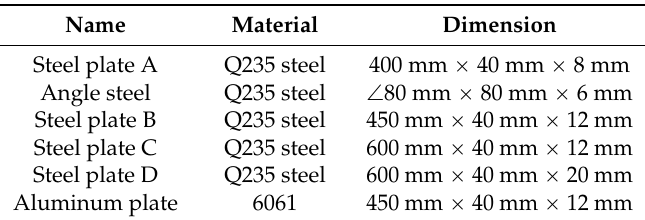
Table 2. Test samples material and dimension.